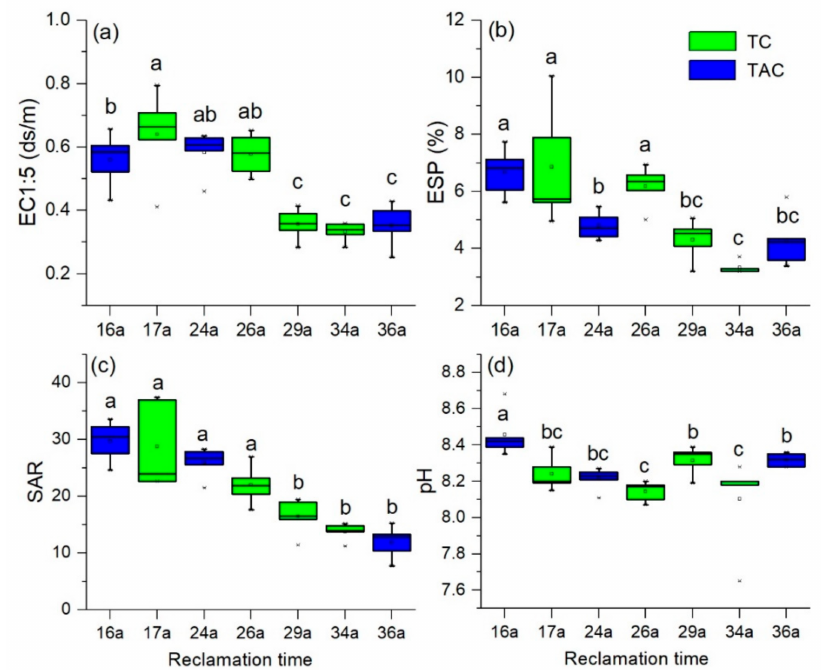
Figure 2. Soil EC1:5 ( a ), exchange sodium percentage (ESP) ( b ), sodium adsorption ratio (SAR) ( c ) and pH ( d ) in the different reclamation zones. Values represent the means ± Standard Deviations (SDs). Different letters indicate significant differences among different reclamation years (LSD, p < 0.05). 16a, 17a, 24a, 26a, 29a, 34a and 36a indicate reclamation years of 16, 17, 24, 26, 29, 34 and 36,